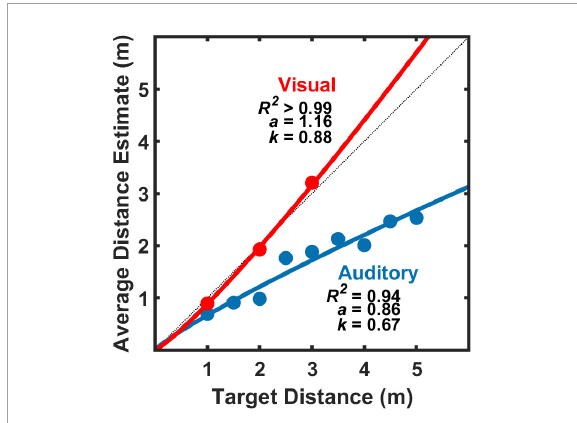
FIGURE4 Average (geometric mean) estimates of target distance for auditory stimuli alone and for visual stimuli alone ( n = 11) as a function of physical target distance For each modality, the data were fit with power functions of the form: y = kx a , where y is the average distance estimate, x is the physical target distance. Parameter estimates for k and a are shown for each modality, as is the proportion of distance estimate variance explained by the power function fit ( R 2 ).